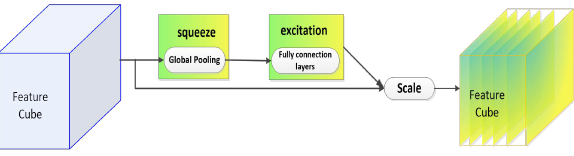
Figure 4 . SEnet network